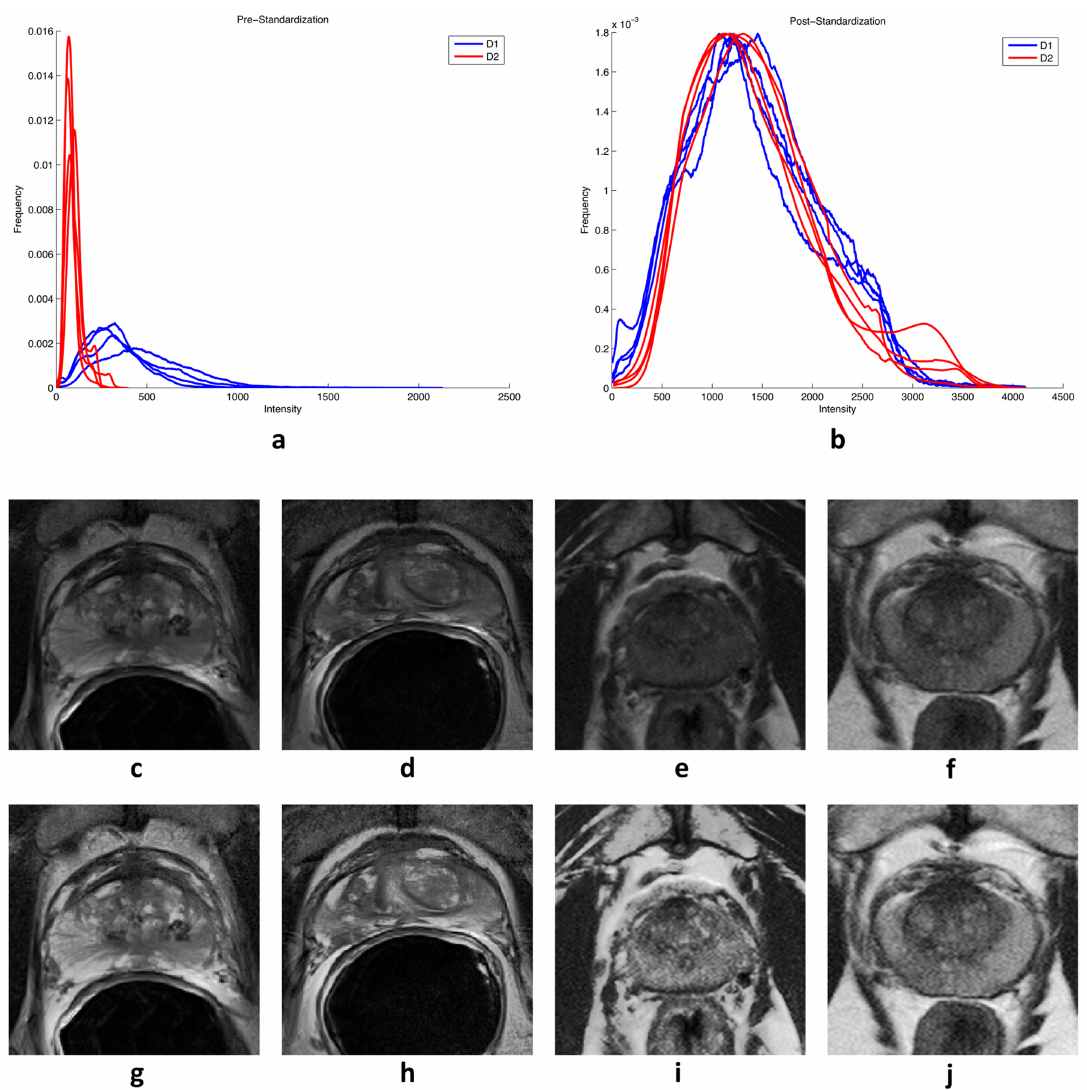
Fig 3. (a) T2w MRI intensity distributions prior to standardization for four patients from D 1 (blue) vs. four patients D 2 (red), demonstrating poor inter- and intra-institutional alignment between intensity distributions of different patients. (b) After standardization to a template constructed from D 1 , the intensity distributions demonstrate better alignment. (c-f) Sample T2w MRI images pre-standardization and (g-j) post-standardization for (c,d,g,h) two patients from D 1 and (e,f,i,j) two patients from D 2